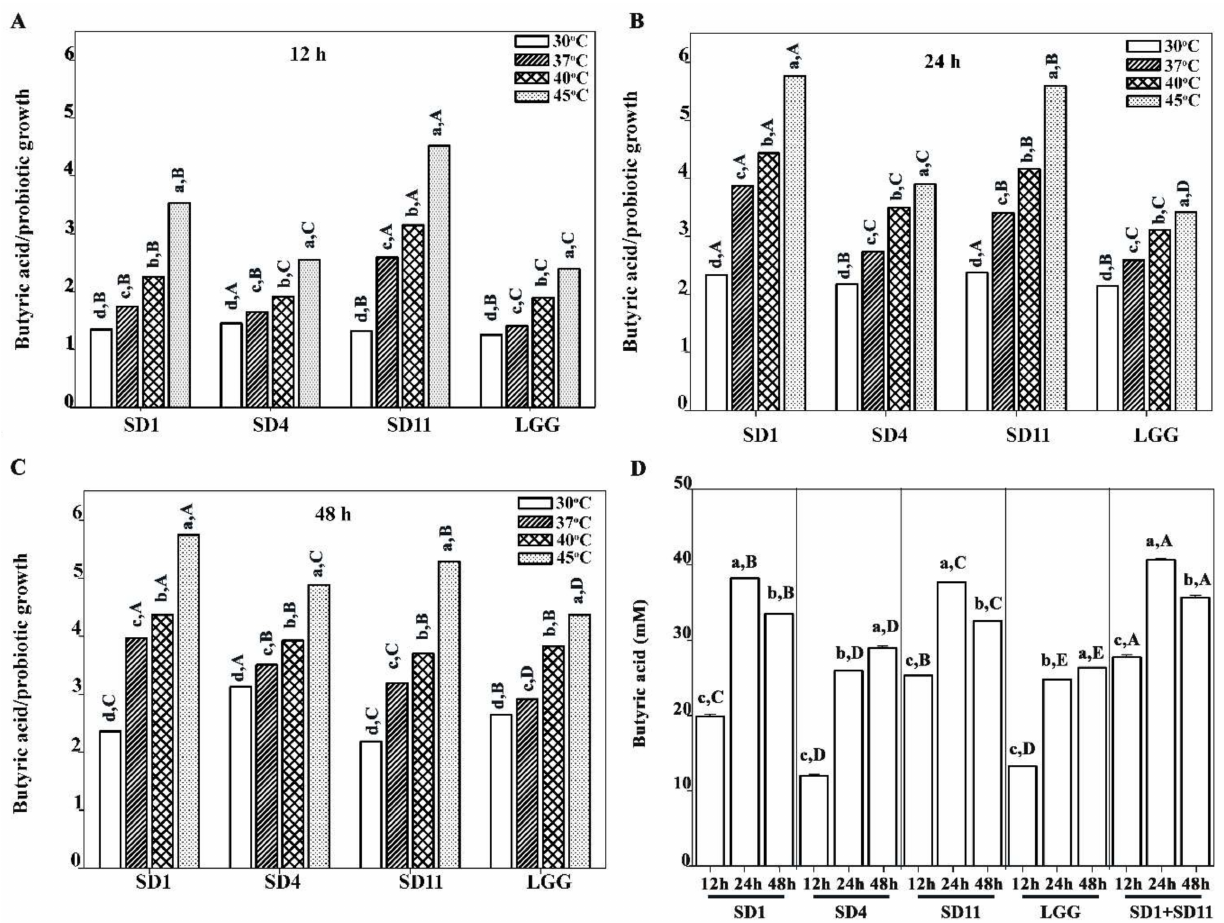
Figure 3. Ratio of butyric acid production and bacterial growth rate at different incubation times: ( A ) 12 h, ( B ) 24 h, and ( C ) 48 h; ( D ) butyric acid production (mM) by probiotics cultured at 45 ◦ C at various incubation times of 12, 24, and 48 h. Lowercase letters show significant differences between different incubation temperatures ( A – C ) or significant differences between different incubation times ( D ) at each probiotic strain ( p < 0.05). Uppercase letters show significant differences between different probiotic strains ( A – C ) at each incubation temperature or show significant differences between different probiotic strains at each incubation time ( D ) ( p < 0.05). Statistical analysis was performed with the Kruskal–Wallis test, followed by the Mann–Whitney U